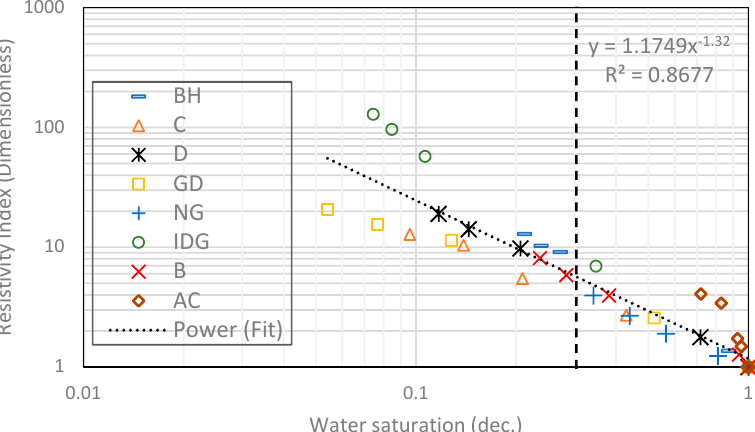
Figure 7. Power-law relationship between rock electrical resistivity and water saturation in a foam-water system.